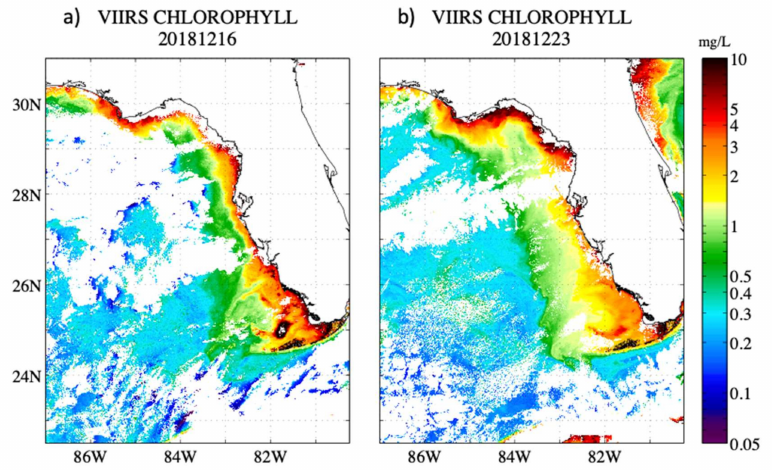
Figure 12. ( a ) Surface CHL product (VIIRS) 16 December and ( b ) surface CHL product (VIIRS) 23 December.